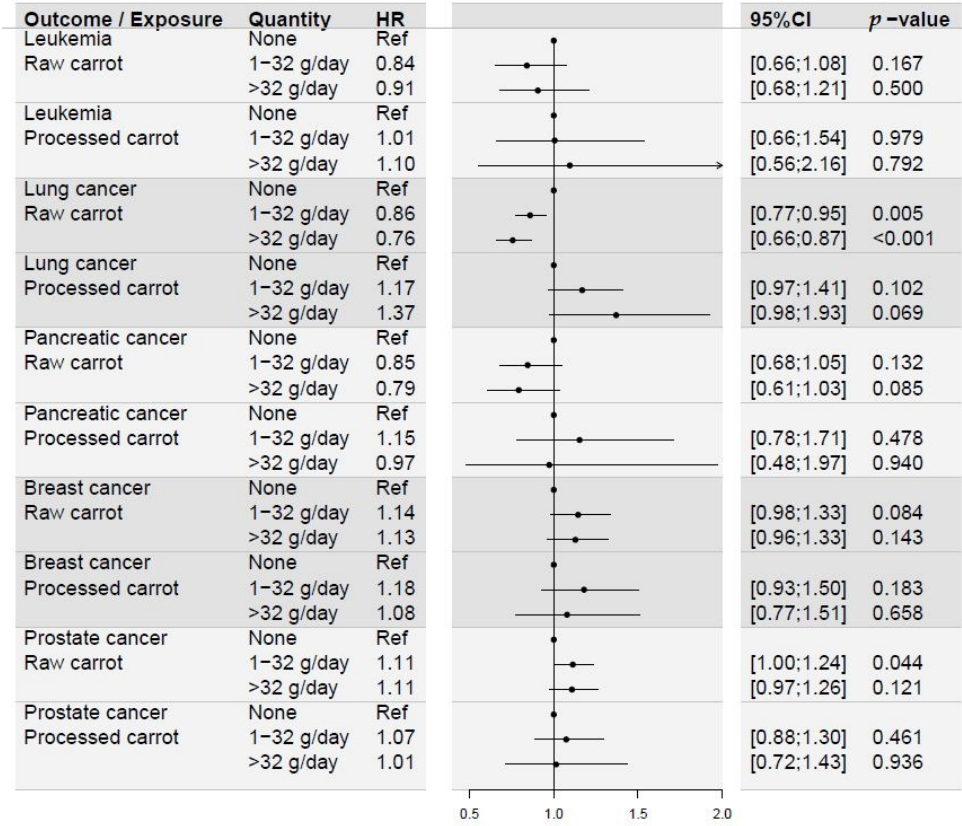
Figure 2. Forest plot illustrating the results from multivariate Cox proportional hazards regression models estimating the risk of the outcomes listed on the basis of carrot intake. All models were adjusted for sex, age group, MET score, other vegetable consumption, other root vegetable con- sumption, NSAID intake, smoking status, educational level, alcohol consumption, BMI, and former cerebral or coronary artery thrombosis. Breast cancer analysis was additionally adjusted for hormone replacement therapy. Leukemia, lung cancer, and pancreatic cancer, n = 55,765. Breast cancer, n = 29,152. Prostate cancer, n = 26,613.